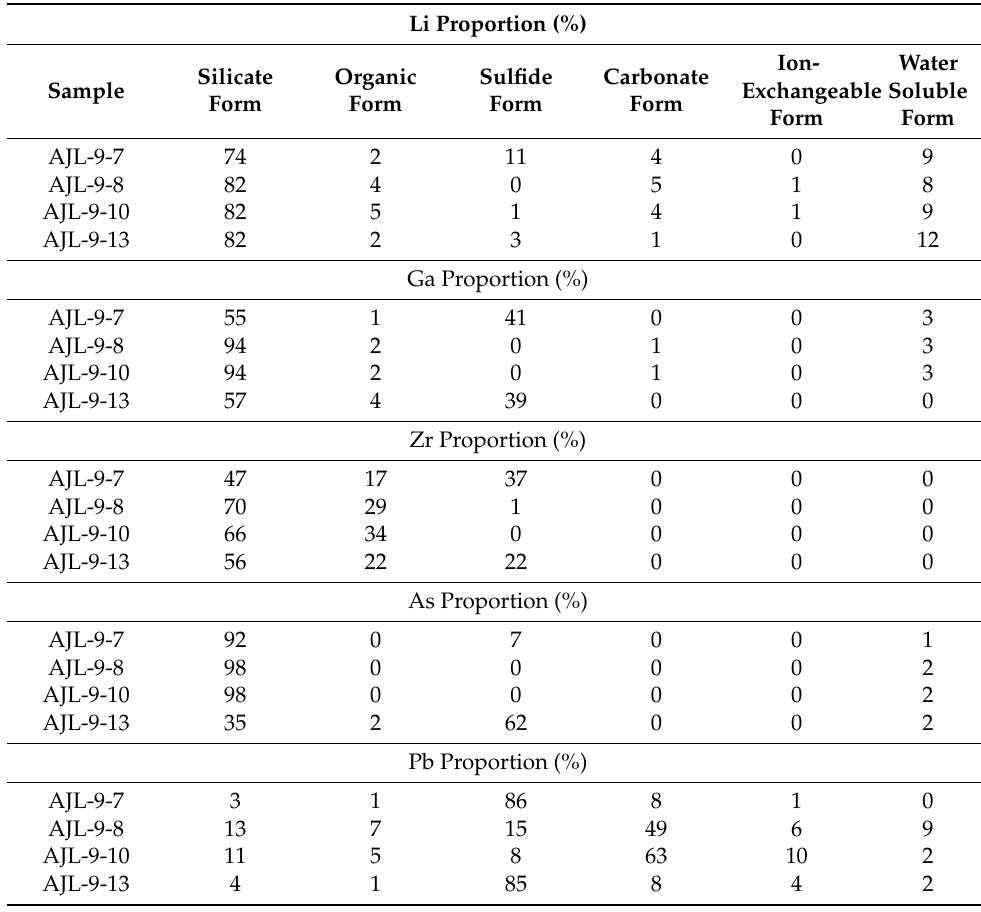
Table 4. Modes of occurrence of Li, Ga, As, Zr, and Pb in the Anjialing coal